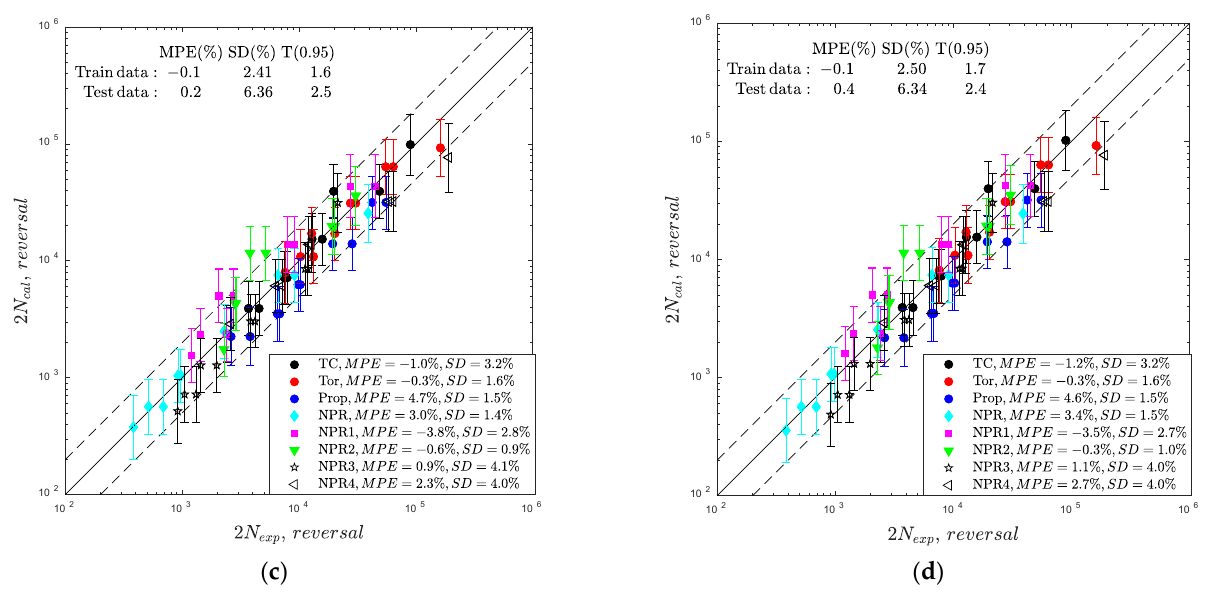
Figure 8. Comparison of experimental and calculated fatigue lives for the fatigue GP-based model for the second training dataset and the following covariance functions: ( a ) Matern 3/2, ( b ) Matern 5/2, ( c ) RQ, and ( d ) SE.